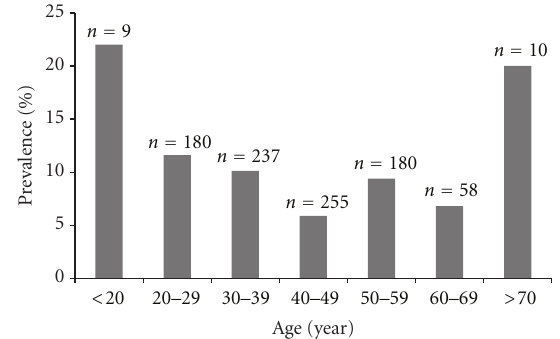
Figure 1: Age-specific prevalence of human papillomavirus (HPV) infection among